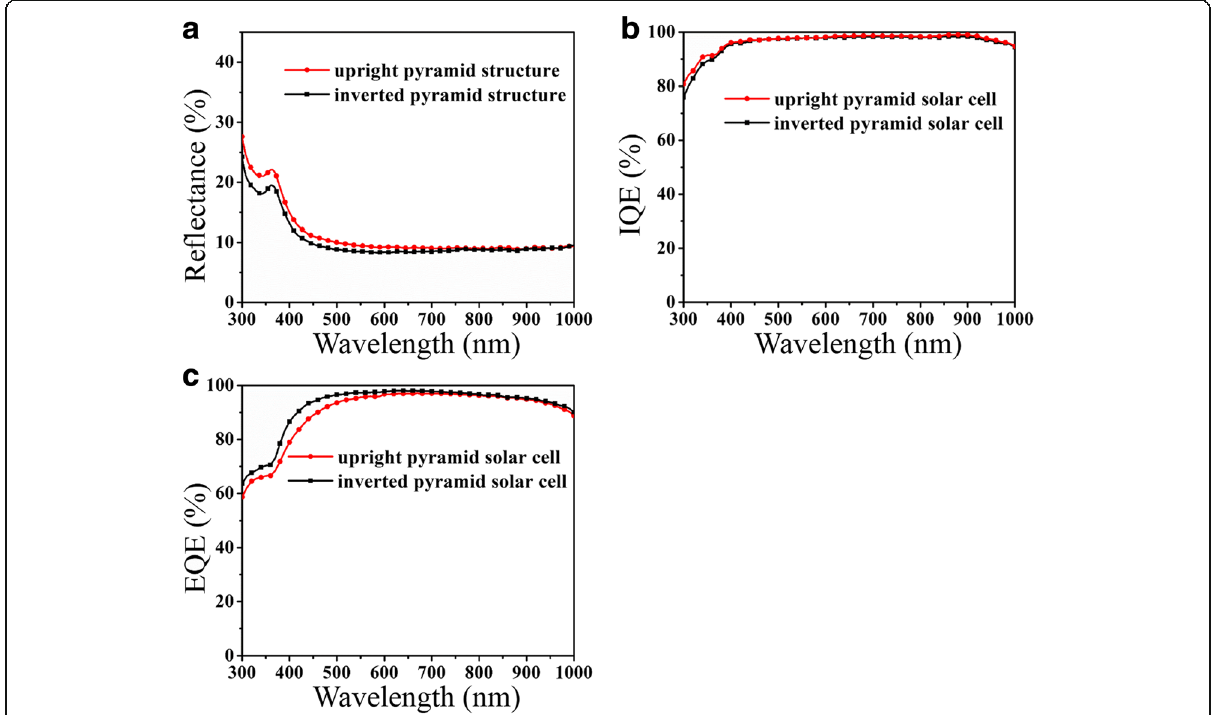
Fig. 6 Comparison of a reflectance spectra, b IQE, and c EQE. a Reflectance spectra of inverted and upright pyramid structures. b IQE and c EQE of inverted and upright pyramid sc-Si solar cells